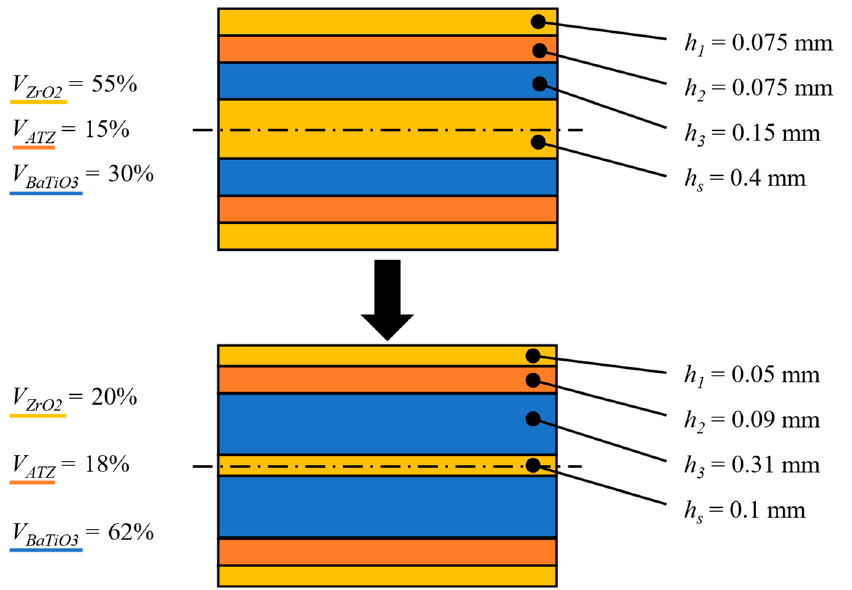
Figure 5. The second phase of optimization showing the input configuration from the first optimization phase ( top ) and the resulting ideal layer composition for the multilayer piezoelectric harvester ( bottom ).